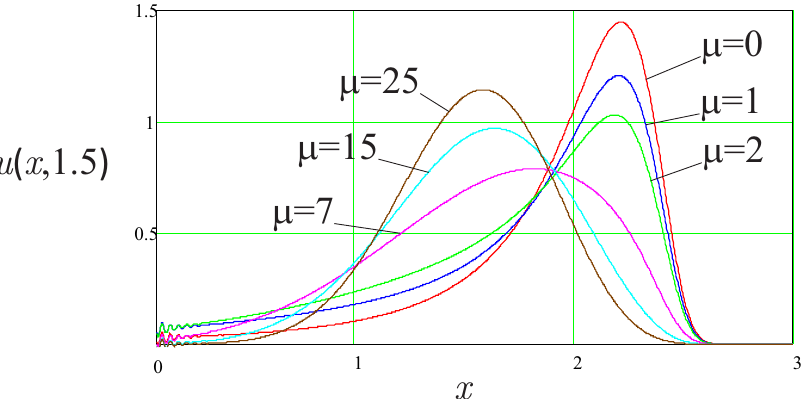
Figure 3. Solution (30) for large values of of µ and for t = 1.5, a = 0.2, b = 1, α =